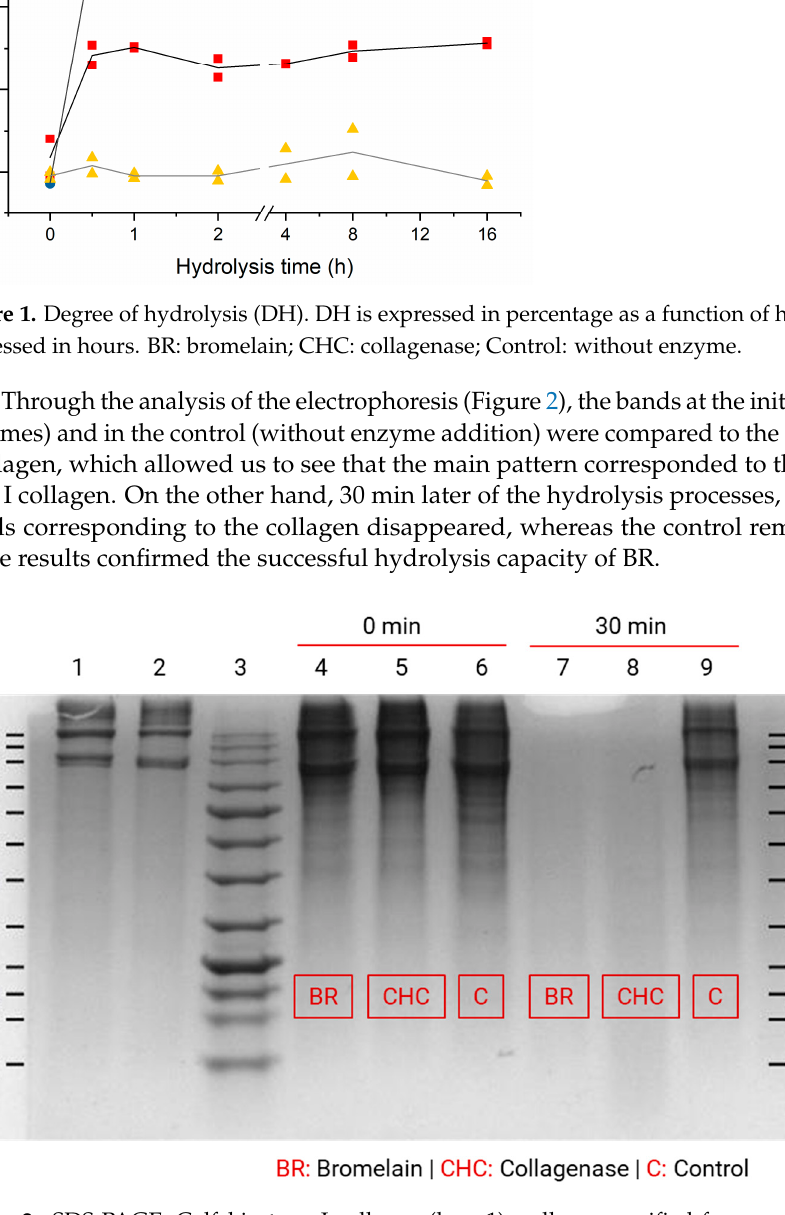
Figure 2. SDS-PAGE: Calfskin type I collagen (lane 1), collagen purified from cod skin by acid methodology (lane 2); molecular weight marker (lane 3); initial time of the hydrolysis with bromelain (lane 4), collagenase (lane 5) and control (lane 6); hydrolysis at 30 min with bromelain (lane 7), with collagenase (lane 8) and control (lane 9). Molecular weight in kDa.